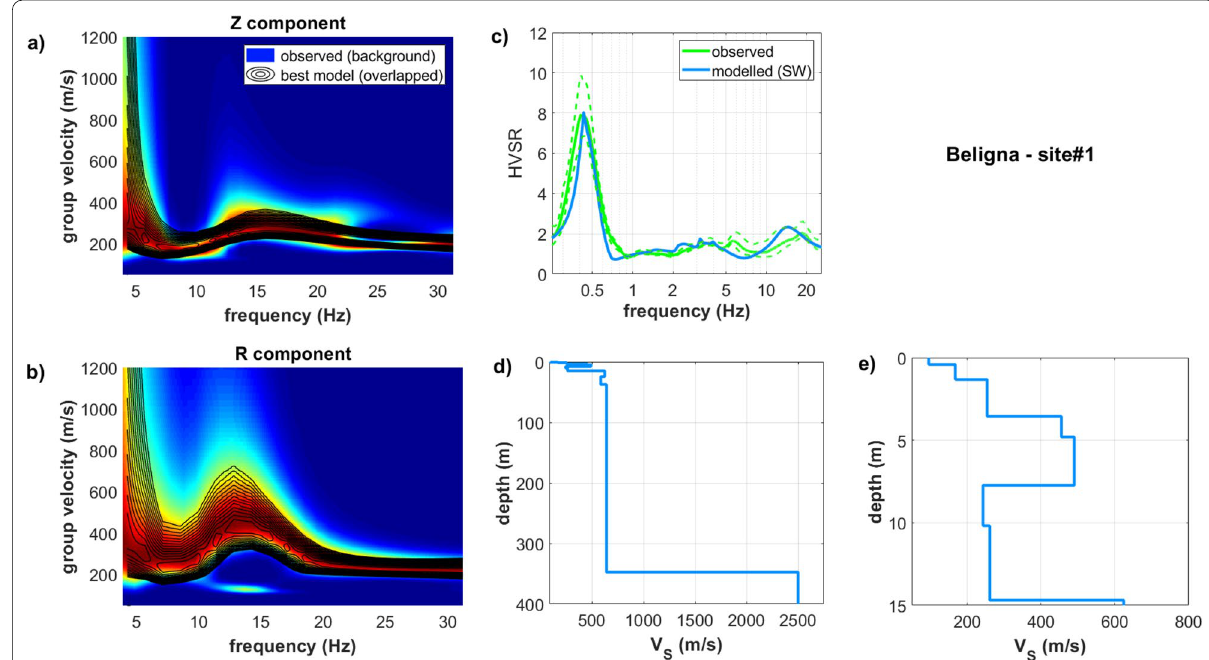
Fig. 13 Beligna#1—central area (HS1). Joint analysis of the active HS and passive HVSR data: a group velocity spectra of the Z component; b group velocity spectra of the R component; c field (green lines—shown the mean curve and the standard deviation) and synthetic (blue line) HVSR curves; d obtained V S profile (down to 400 m); e close-up of the shallow part (first 15 m) of the obtained V S profile. The HVSR peak at about 0.43 Hz is related to the deep bedrock